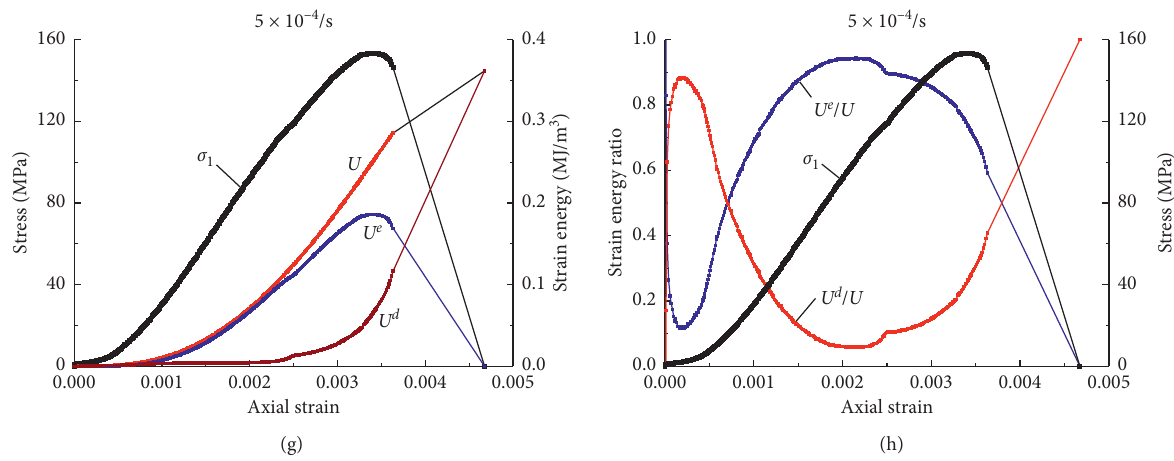
Figure 8: Energy evolution mechanism of the karst limestone under different strain rates. (a) Energy curves at 5 × 10 − 6 /s. (b) Energy ratio curves at 5 × 10 − 6 /s. (c) Energy curves at 2 × 10 − 5 /s. (d) Energy ratio curves at 2 × 10 − 5 /s. (e) Energy curves at 1 × 10 − 4 /s. (f) Energy ratio curves at 1 × 10 − 4 /s. (g) Energy curves at 5 × 10 − 4 /s. (h) Energy ratio curves at 5 × 10 − 4 /s.